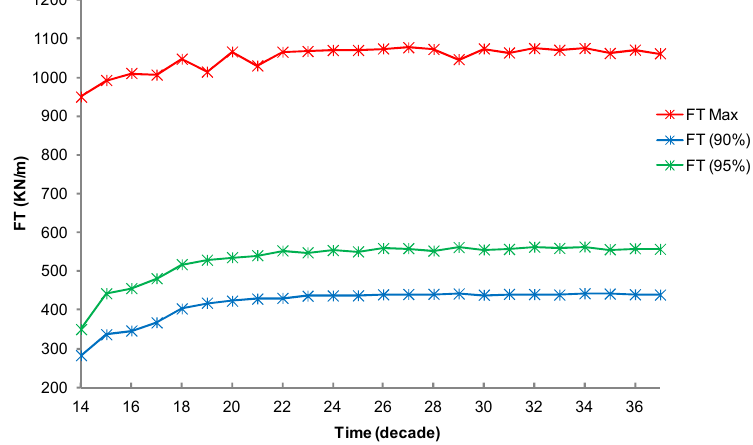
Figure 17. Evolution of F Tmax , and 90%, 95% fractiles with time.